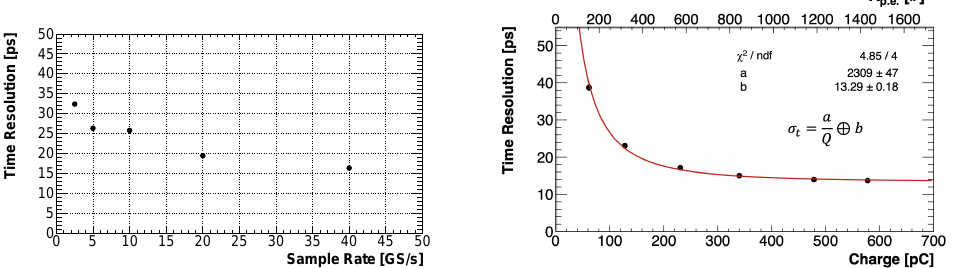
Figure 10. Effect of sampling frequency on time resolution ( left ). Time resolution as a function of charge and N p.e. ( right